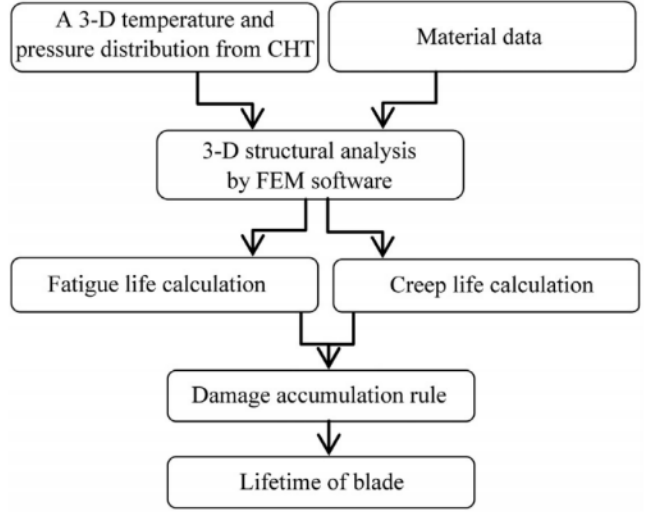
Figure 5. Flow chart of a typical estimation procedure. Adapted from Ref. [54].